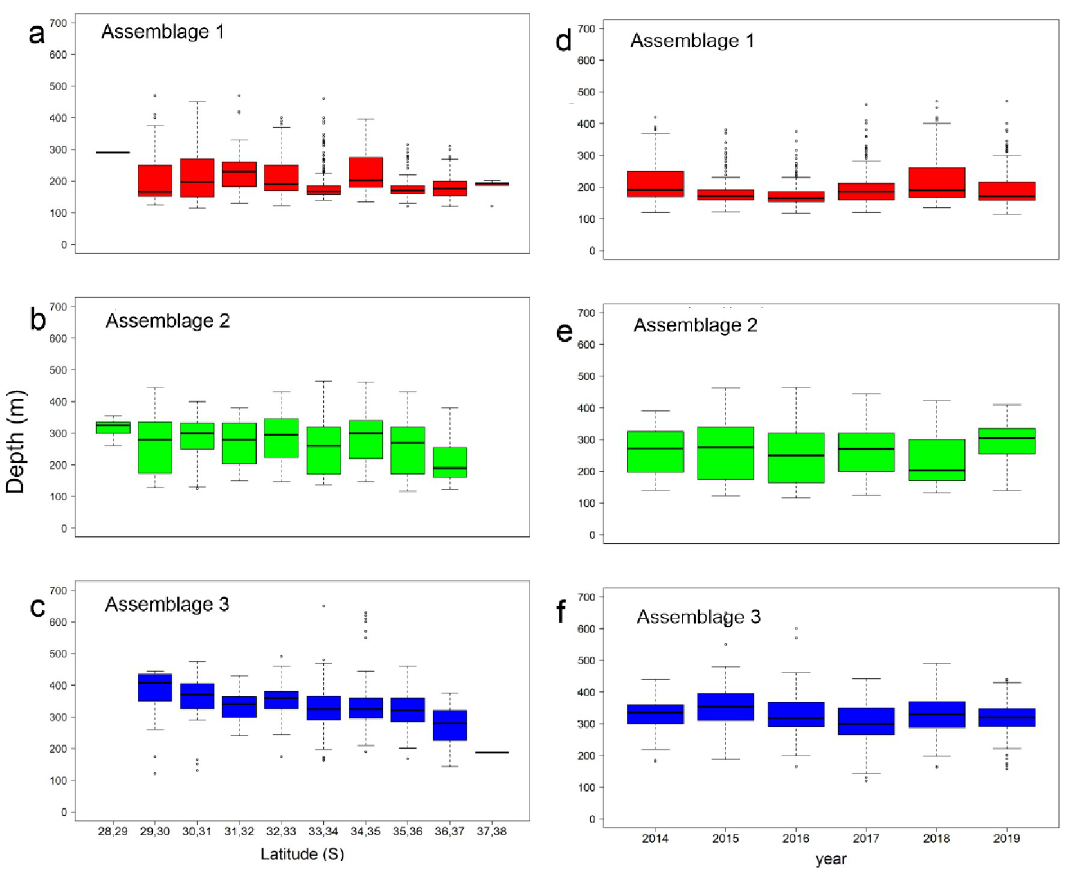
Fig 4. Boxplots (mean, standard deviation, maximum and minimum) of depth distribution for each assemblage identified by the multivariate analyses and defined in Table 2, by latitude (a, b, c) and year (d, e, f).